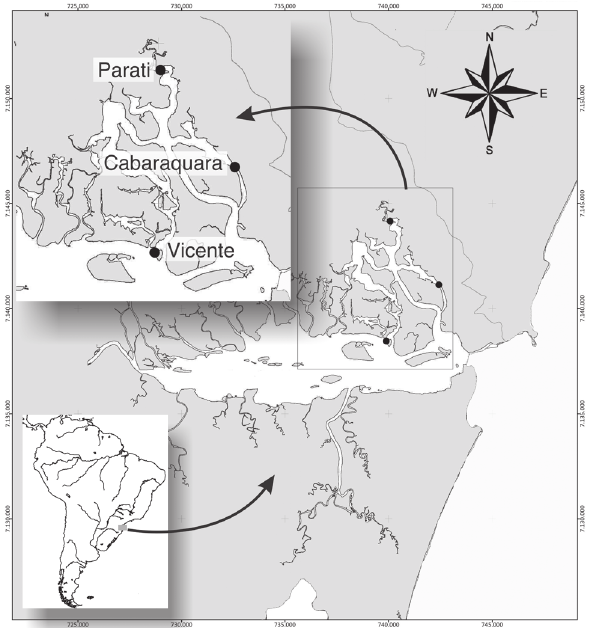
Figure 1. Location of the Guaratuba Bay and identification of col- lection sites for plankton and spat samples of native species of Crassostrea . Geographic coordinates are in